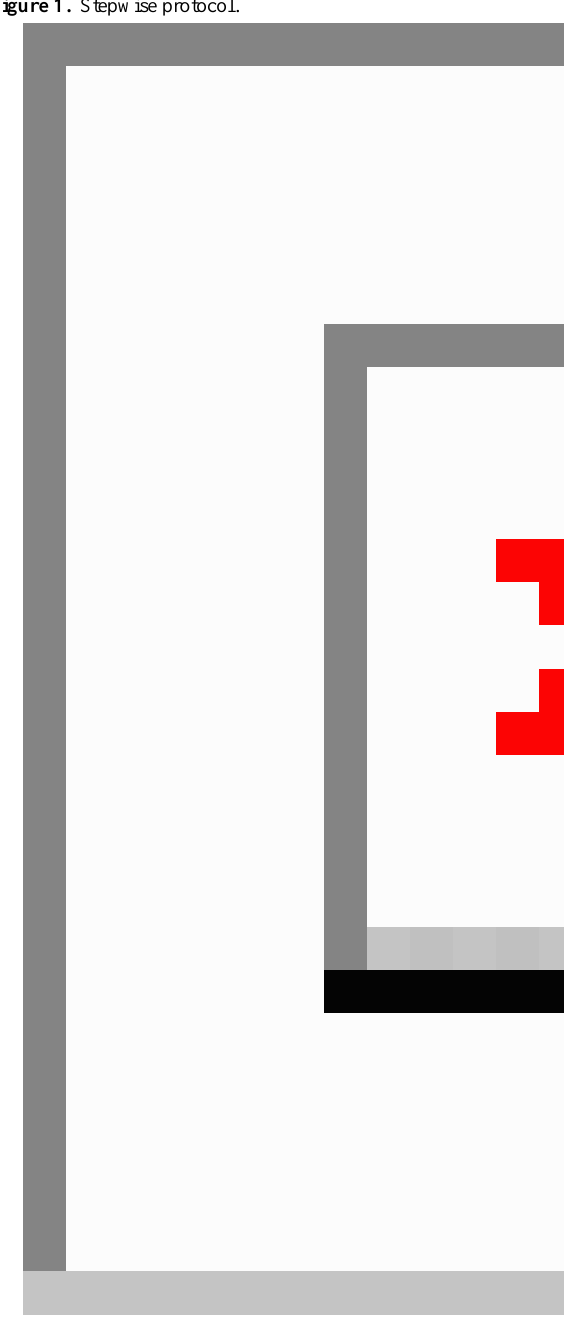
Figure 1. Stepwise